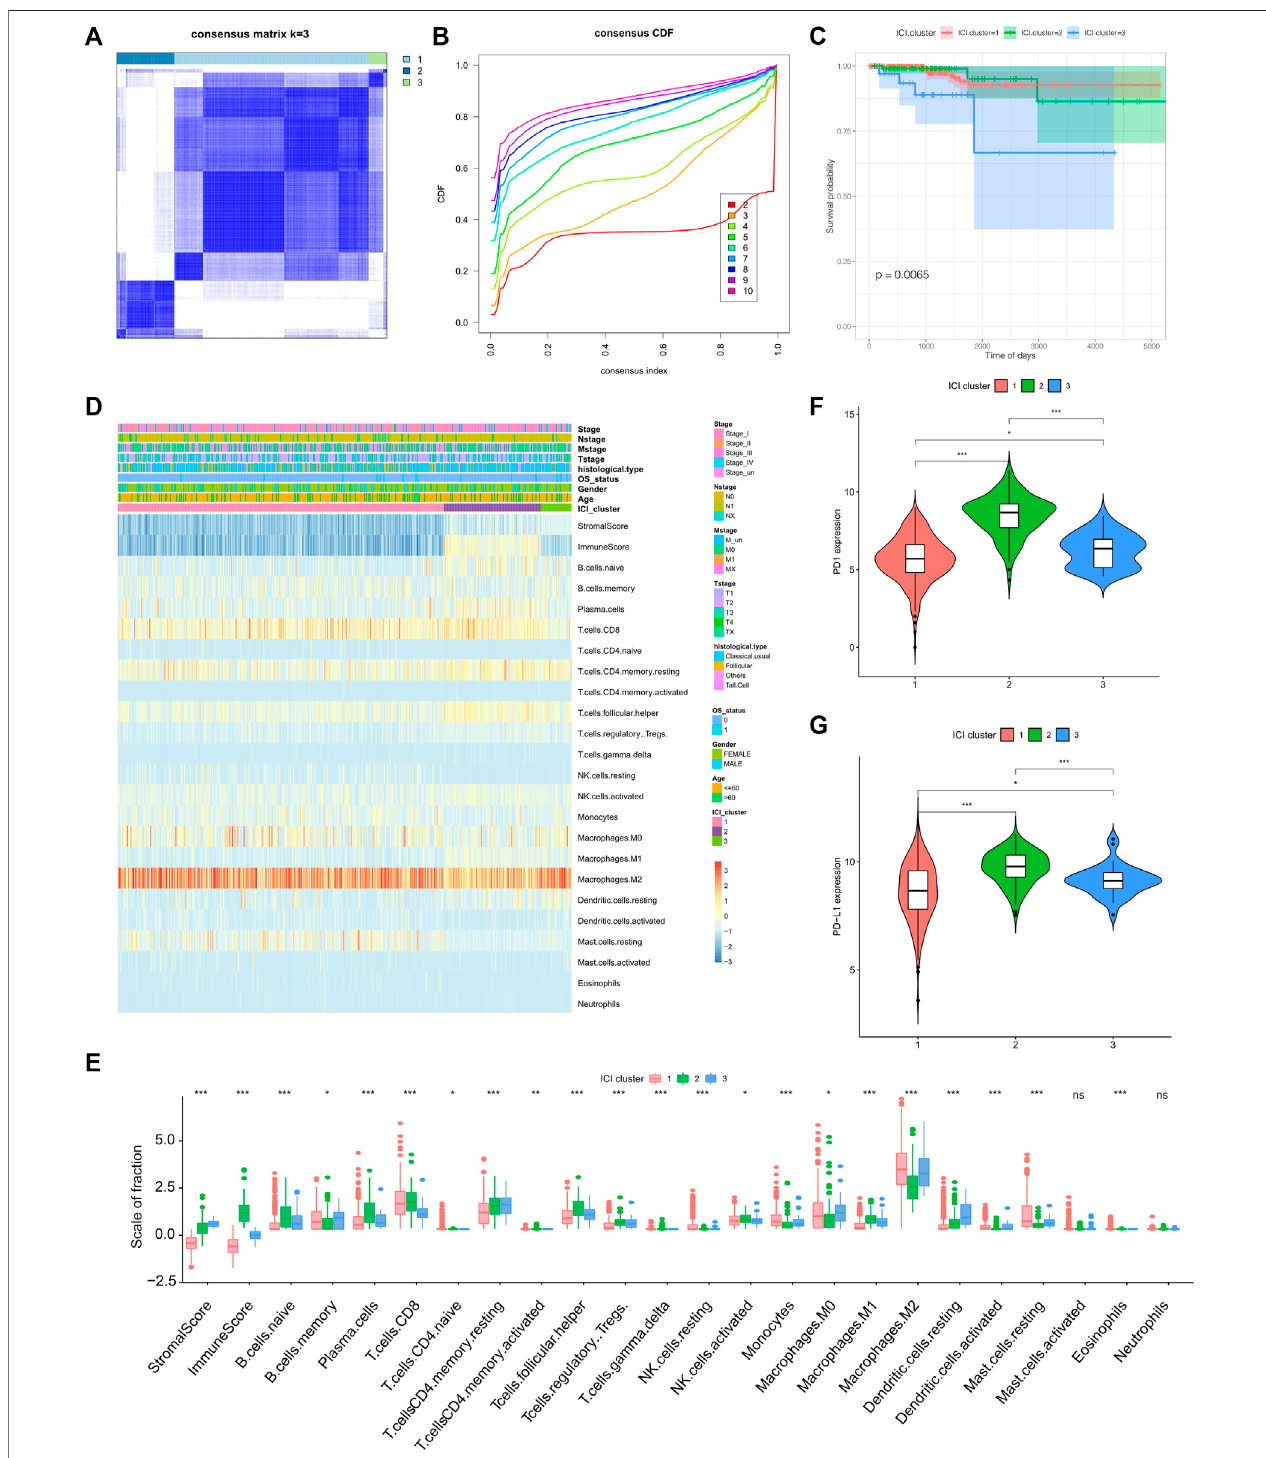
FIGURE 1 | Identi fi cation of tumor immune subtypes and characteristics of immune in fi ltration. (A) Clustering result when k (cid:1) 3; (B) CDF curve distribution of consistent clustering; (C) Survival curve when K (cid:1) 3; (D) Heat map of immune cell in fi ltration characteristics; (E) Box diagram of differences in immune cell in fi ltration characteristics among the three ICI subtypes; (F) The expression difference of PD1 among the three ICI subtypes; (G) the expression difference of PD-L1 among the three ICI subtypes.